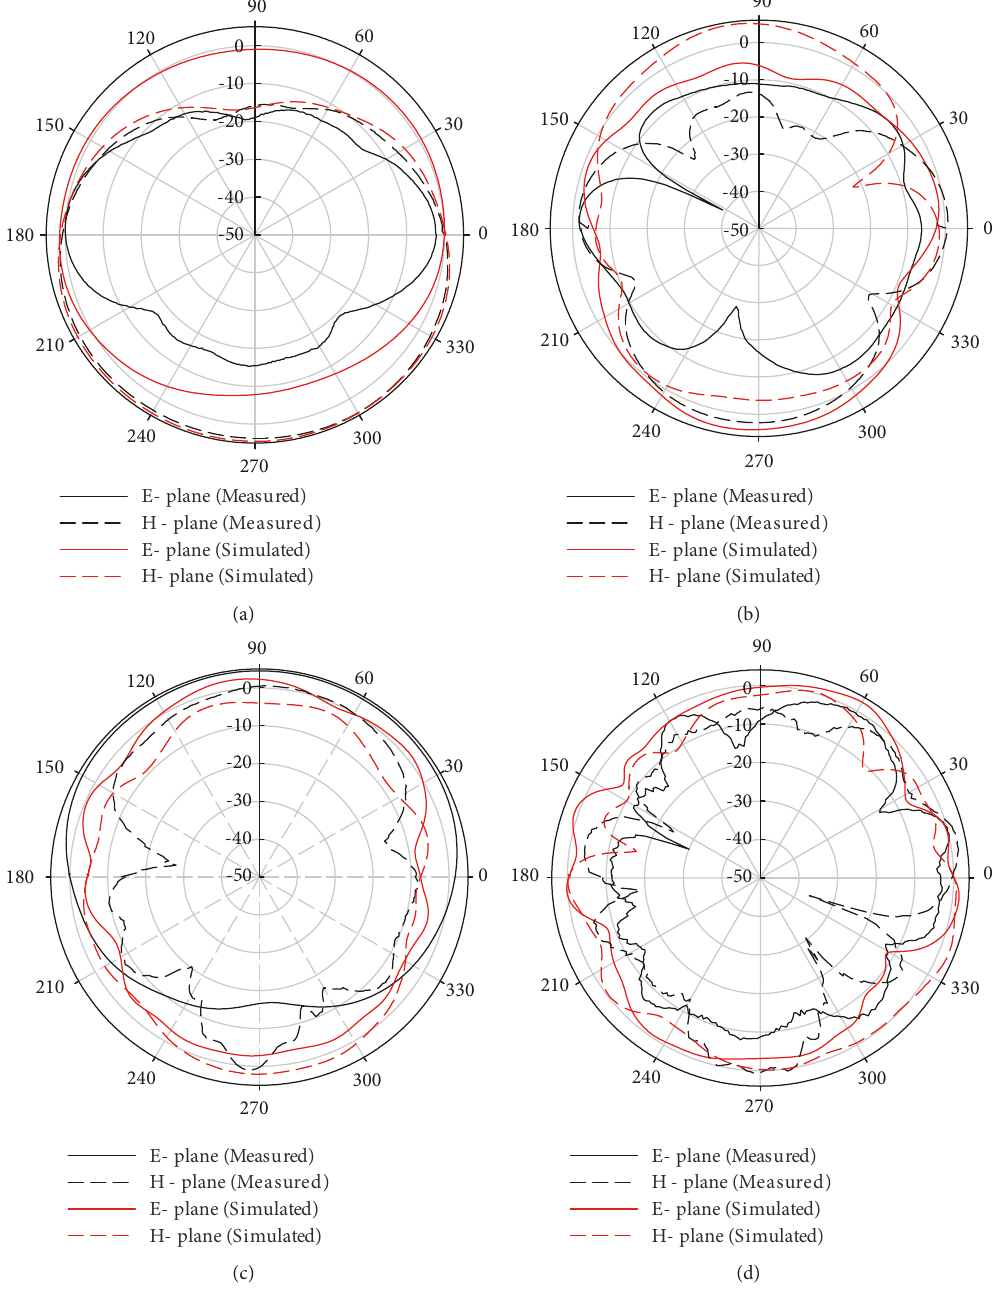
Figure 6: Measured and simulation radiation pattern at (a) 4.5, (b) 6.5, (c) 11.5, and (d) 16.5 GHz.